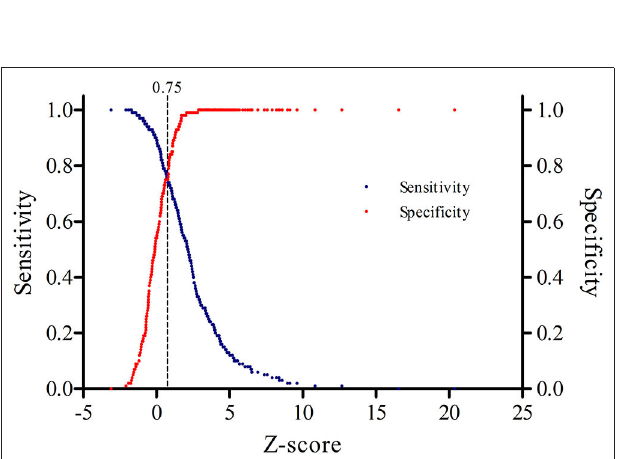
FIGURE 3 | Decision plot showing that a z -score of 0.75 (dotted vertical line) represents the optimal cut-off point for the highest sensitivity and specificity.